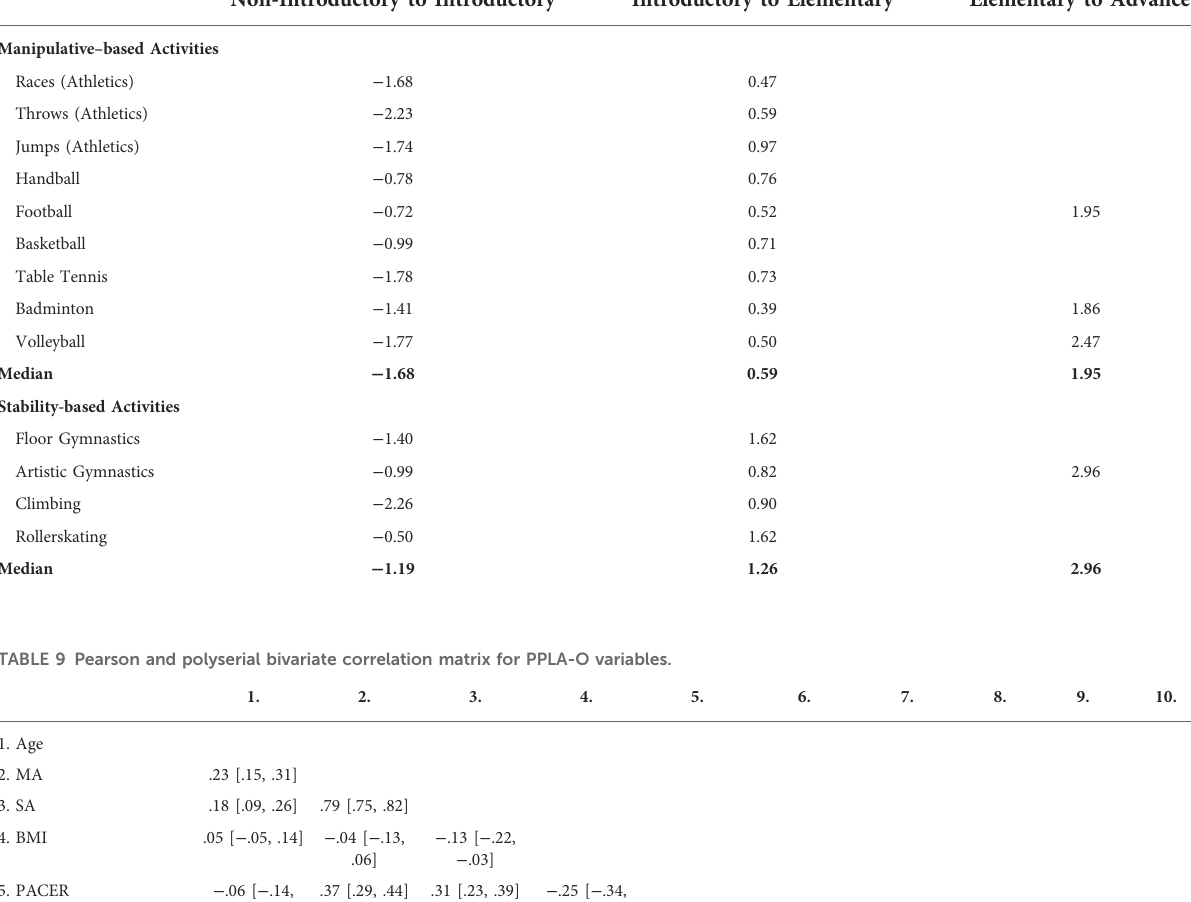
TABLE 8 Dif fi culty of each physical activity pro fi ciency level transition point (threshold).